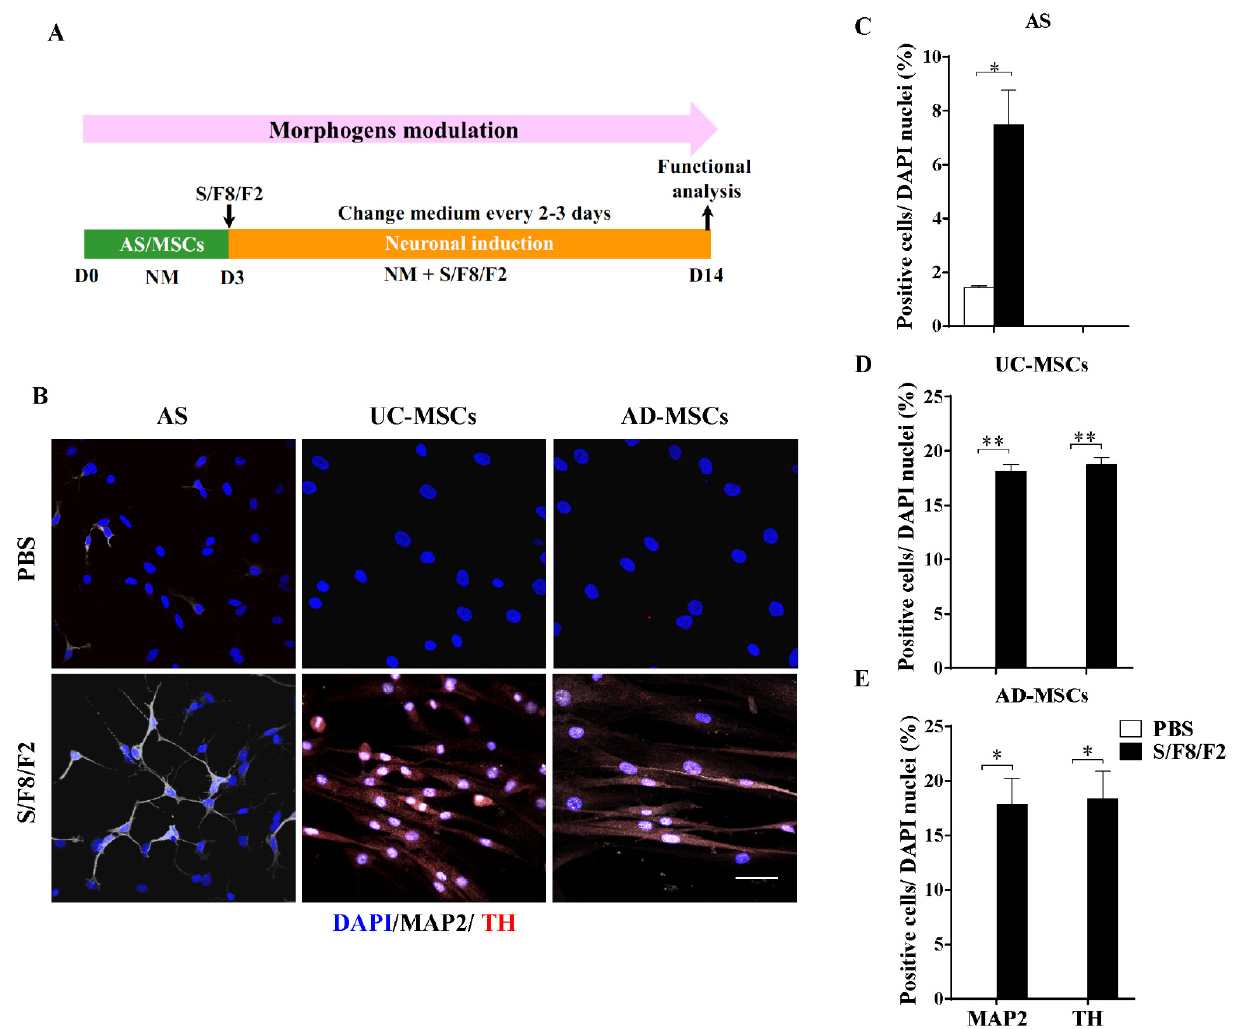
Figure 4. AS and MSCs showed different DA induction potential to the signaling molecules SHH, FGF8, and FGF2. ( A ) AS or MSCs were primed in NM for 3 days, followed by DA induction with signaling molecules SHH, FGF8, and FGF2 (S/F8/F2) till the 14th day. On the 14th day, cells were fixed and subjected to MAP2 and TH immunostaining. ( B ) The representative images of MAP2 and TH double staining showing AS (left column), UC-MSCs (middle column), and AD-MSCs (right column) treated with PBS (upper panel) or S/F8/F2 (lower panel) for 14 days. There were few MAP2- or TH-positive cells in all the PBS-treated cells. S/F8/F2 increased the expression of MAP2 in all three cell types, but only UC-MSCs and AD-MSCs expressed DA-specific marker TH. ( C – E ) The percentages of MAP2- and TH-positive cells induced from AS ( C ), UC-MSCs ( D ), AD-MSCs ( E ) were counted and compared at day 14. Positive cells are included only when the staining was distributed in the nuclei as well as cytoplasm ( n = 3 independent experiments). Scale bars: 50 µm in ( B ). Data represented as mean ± SEM, * p < 0.05, ** p < 0.01 in S/F8/F2-treated cells vs. the corresponding PBS-treated control.